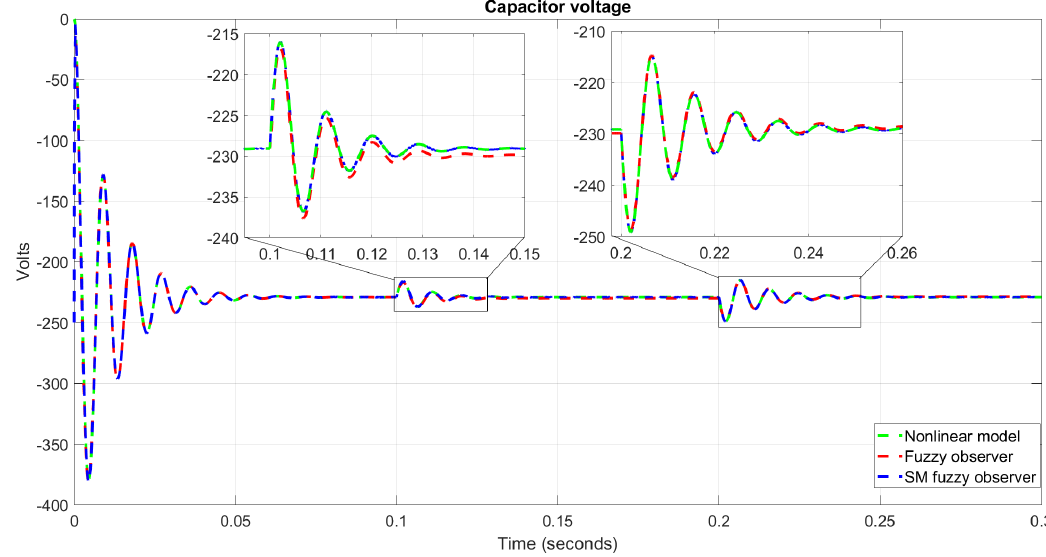
Figure 17. Observer response for the voltage of v C with variations in load R